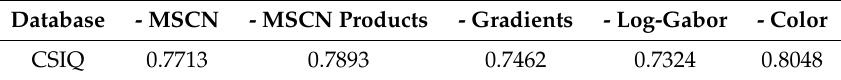
Table 6. The SRCC of using different integrated features on the CSIQ databases. The “- X” means using four kinds of features other than